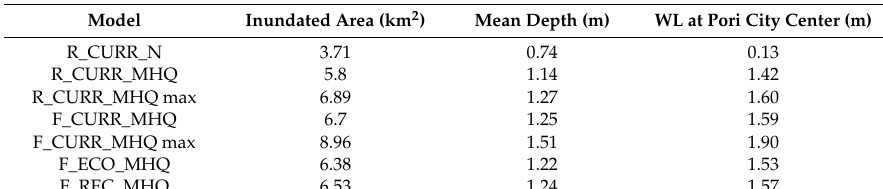
Table 6. The inundated area, mean flow depth, and water level at the Pori city center of each modeled case, based on the 2D hydrodynamic model. The discharges and downstream water levels used in the models are shown in Table 3. The location of the Pori city center is shown in Figure 1c.